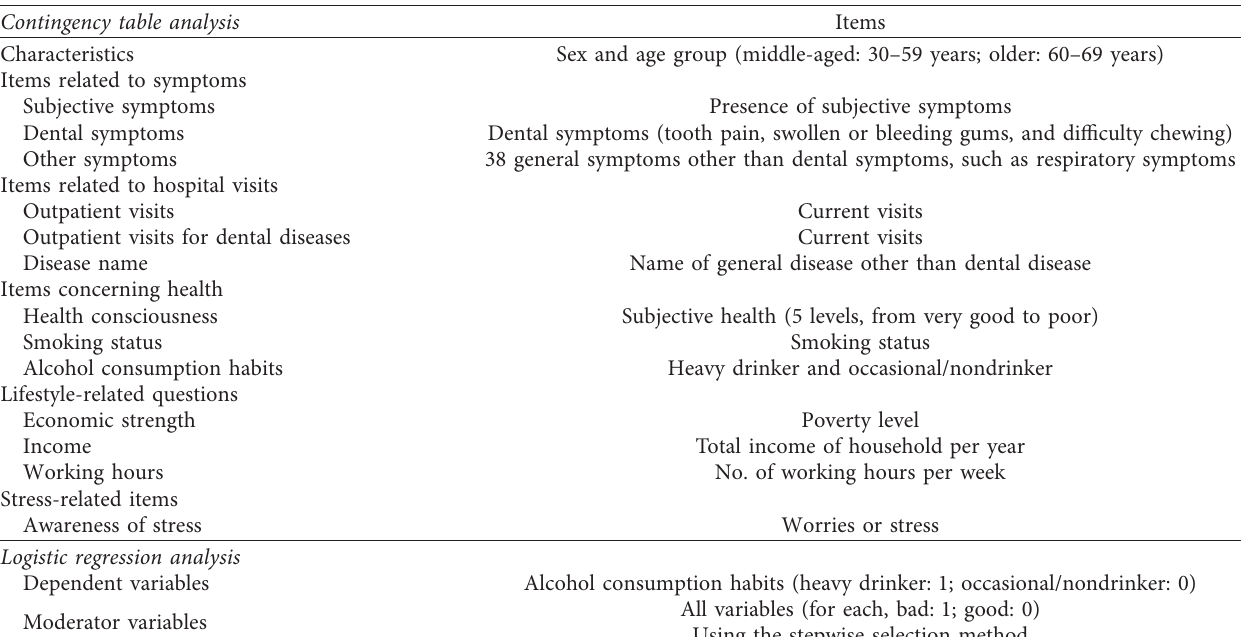
Table 1: Survey items for